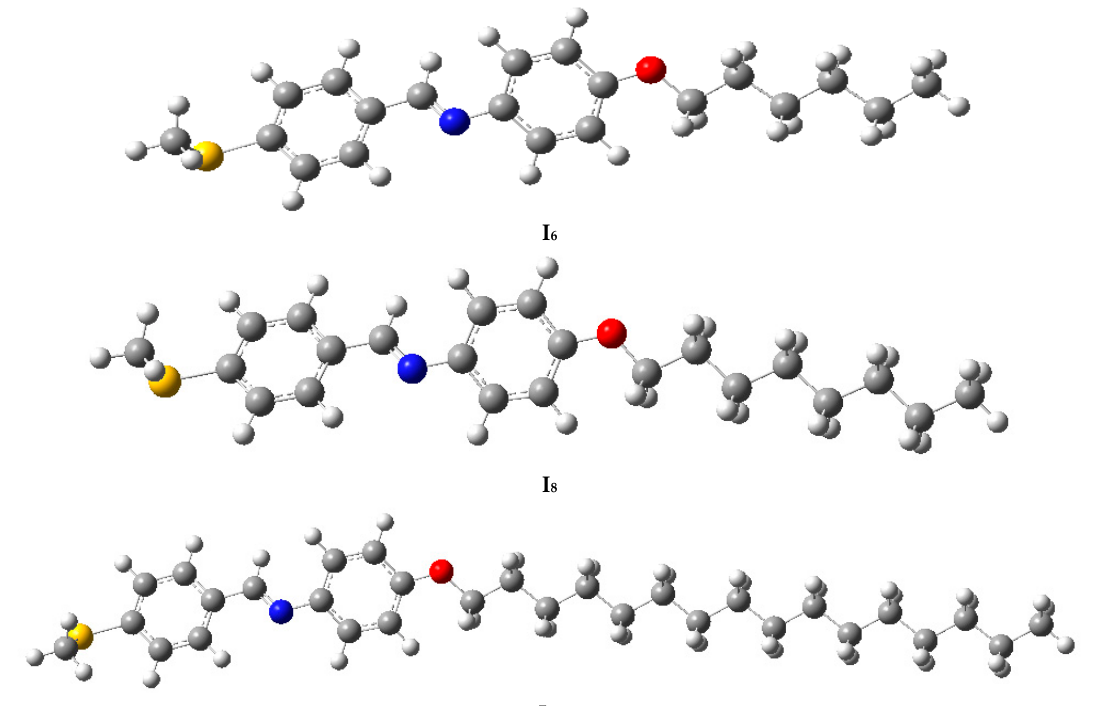
Figure 6. The optimized geometries of the investigated compounds, I